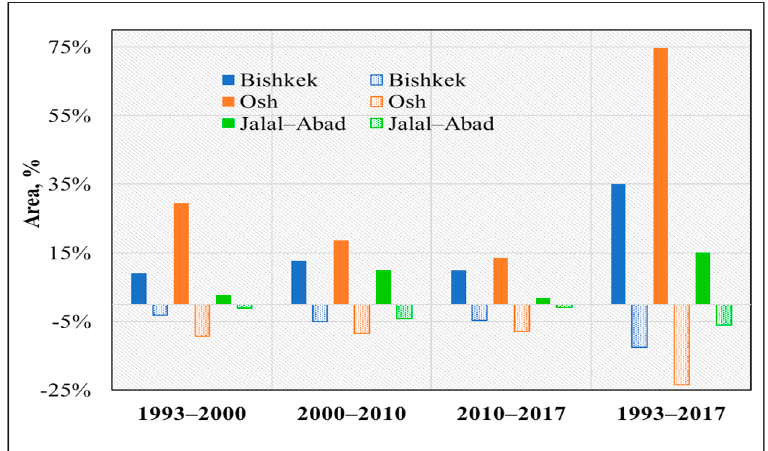
Figure 7. Changes in impervious and nonimpervious surfaces during 1993–2017.